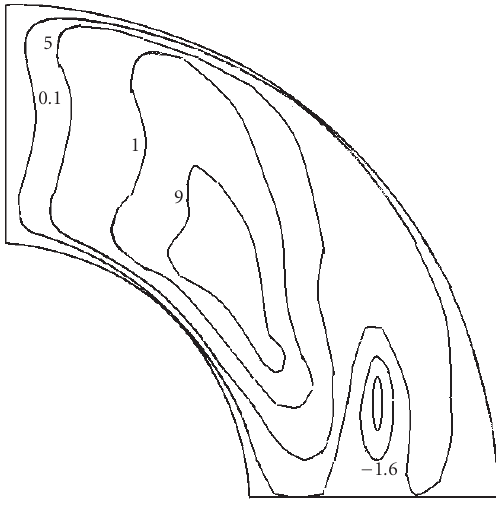
Figure 4.4. Level ψ curves multiplied by 10 4 for Re =